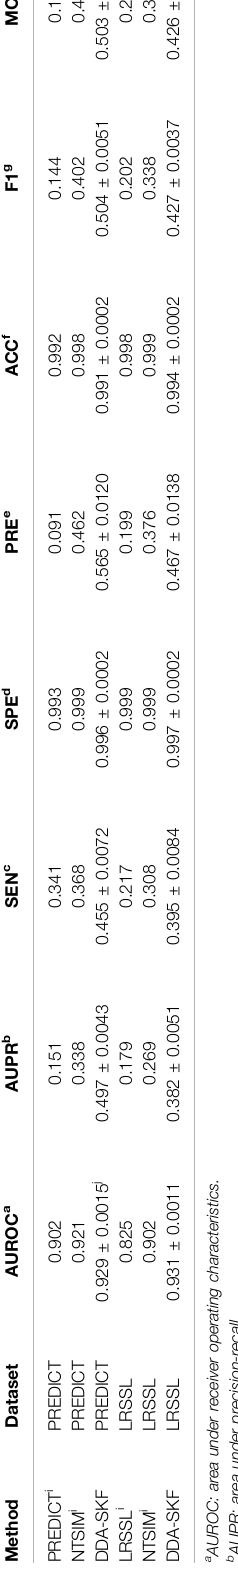
TABLE 3 | Top fi ve candidate diseases for typical drugs. Drug Disease OMIM